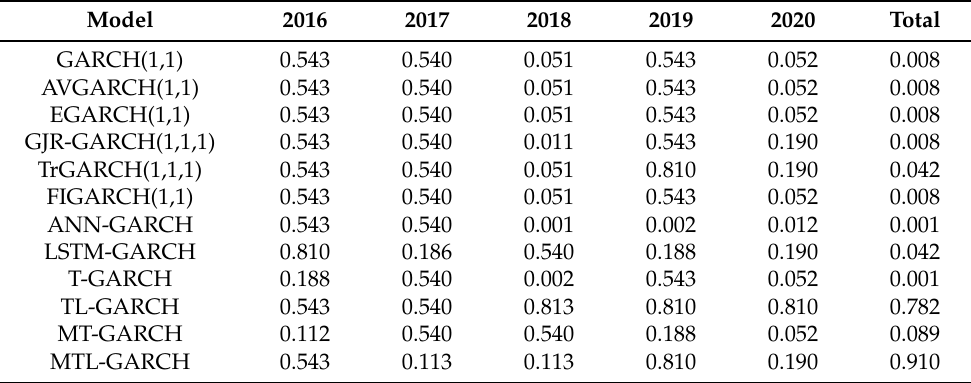
Table 4. Kupiec test ( p -values) by volatility model and